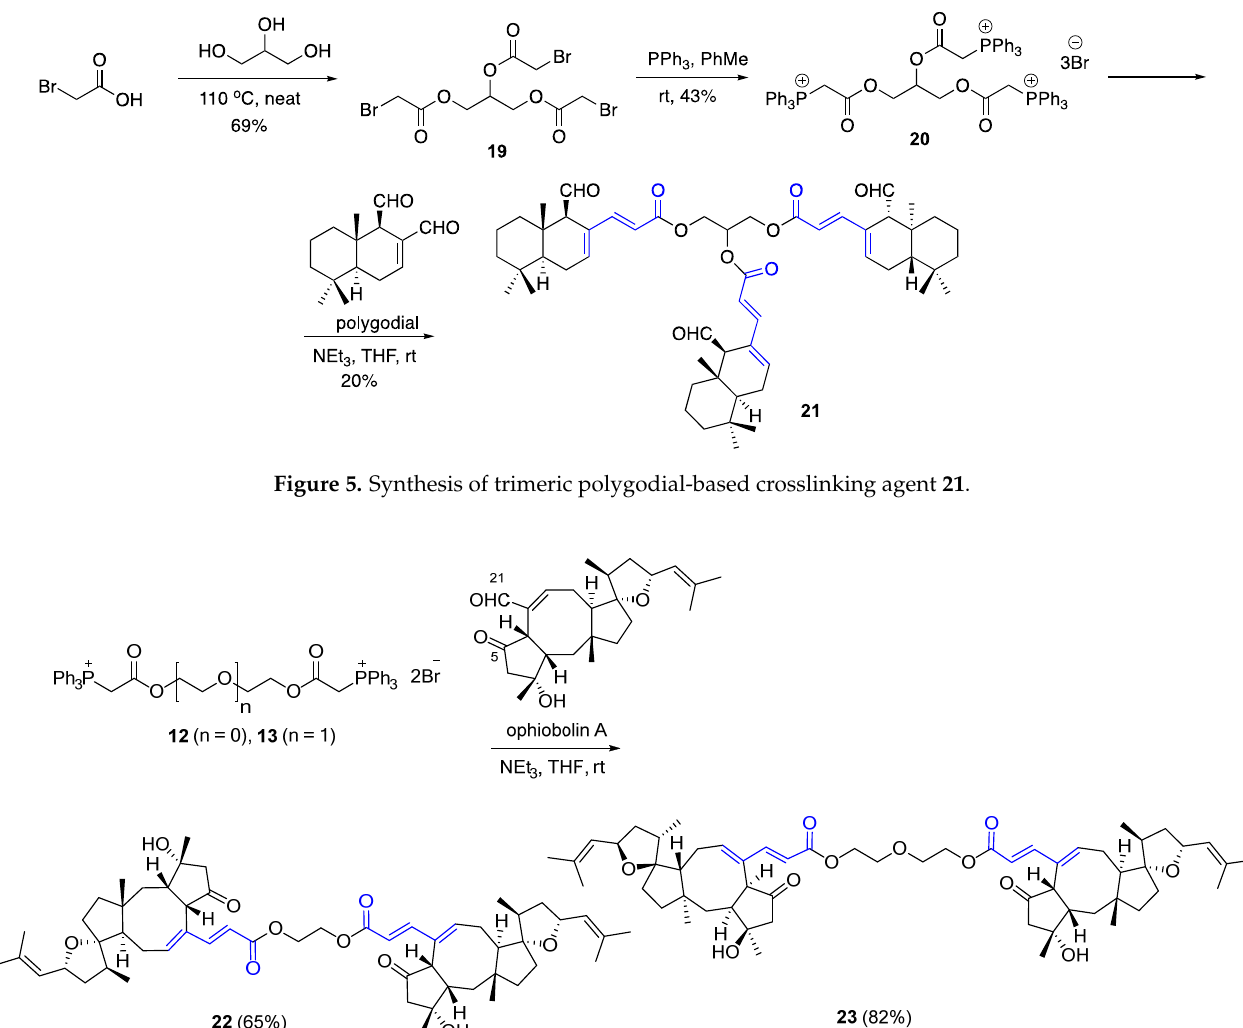
Figure 4. Demonstration of the feasibility of the formation of bis-pyrrole 18 from dimer 15.